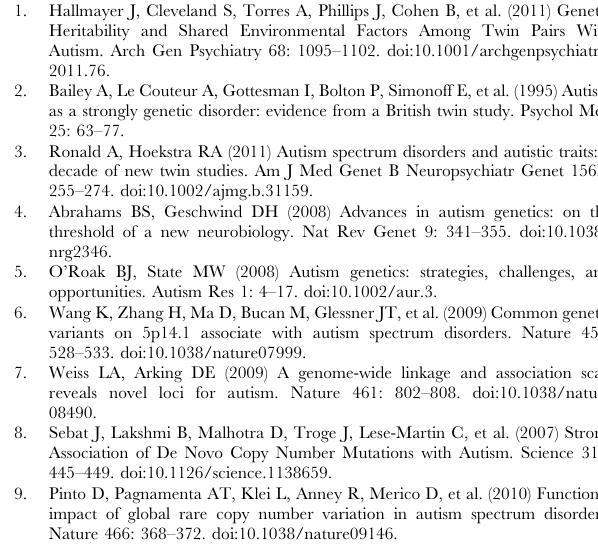
Figure S4 Top connections in the WGCNA modules. The top 150 connections in each module are visualized using the Cytoscape Software Package. Nodes are ordered and sized according to their degree. Figure S5 Quality control measures for GWAS. MDS clustering (A) and Q-Q (B) plots are shown for the AGP (left) and SSC (right) cohorts. (A) An MDS plot was generated incorporating samples from the HapMap Project Phase III. On this, clustering was performed using the Mclust R package. Samples (shown in gray) which did not cluster with the HapMap Caucasian (CEU) cohort (shown in turquoise) were removed from analysis. Han Chinese and Japanese samples are in purple, and Yorubans are in yellow. (B) Q-Q plot was generated by plotting the observed 2 log 10 P against the expected under a uniform P-value distribution. Table S1 List of genes in the WGCNA network, their module affiliation and their degree of membership to each module. Table S2 The gene expression profile of each module, represented by the module eigengene, is shown for different brain regions and samples. Table S3 Overlap of the gene co-expression network results with a previously published network. Table S4 Enrichment of gene ontology (GO) categories in the different modules.